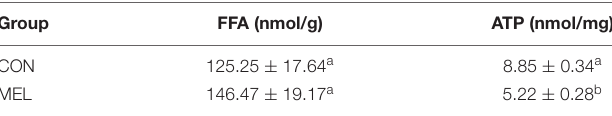
TABLE 3 | Concentrations of FFA and ATP in the muscle tissue of sea cucumbers in the MEL and CON groups. Group FFA (nmol/g) ATP (nmol/mg) CON 125.25 ± 17.64 a 8.85 ± 0.34 a MEL 146.47 ± 19.17 a 5.22 ± 0.28 b Different letters indicate significant differences at p < 0.05 (mean ± SE). FFA and ATP represent the concentrations of FFA and ATP in muscle tissue of sea cucumber